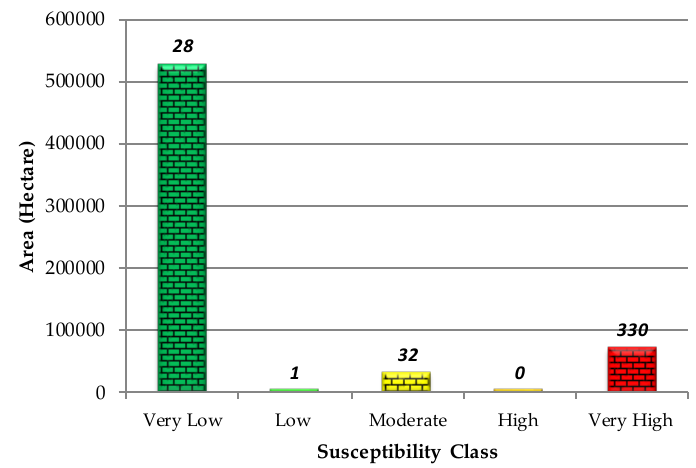
Figure 7. Histogram landslide susceptibility occurrence within each susceptibility class.